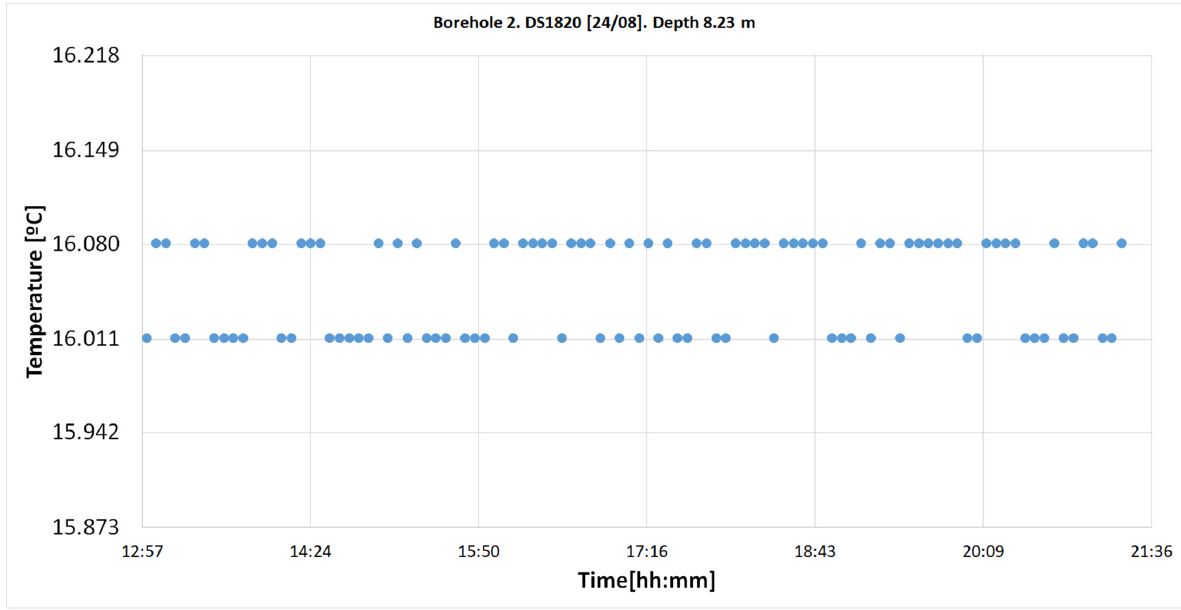
Figure 30. Temperature records on 23 August in the “Q-Thermie-Uniovi.2” borehole with DS18B20 sensor at 8.23 m. It can observed that 53.4% of the measurements are at 16.011 °C and the remaining 46.6% are at 16.080 °C, with a temperature difference of 0.069 °C. Temperatures from Sensor S10.31